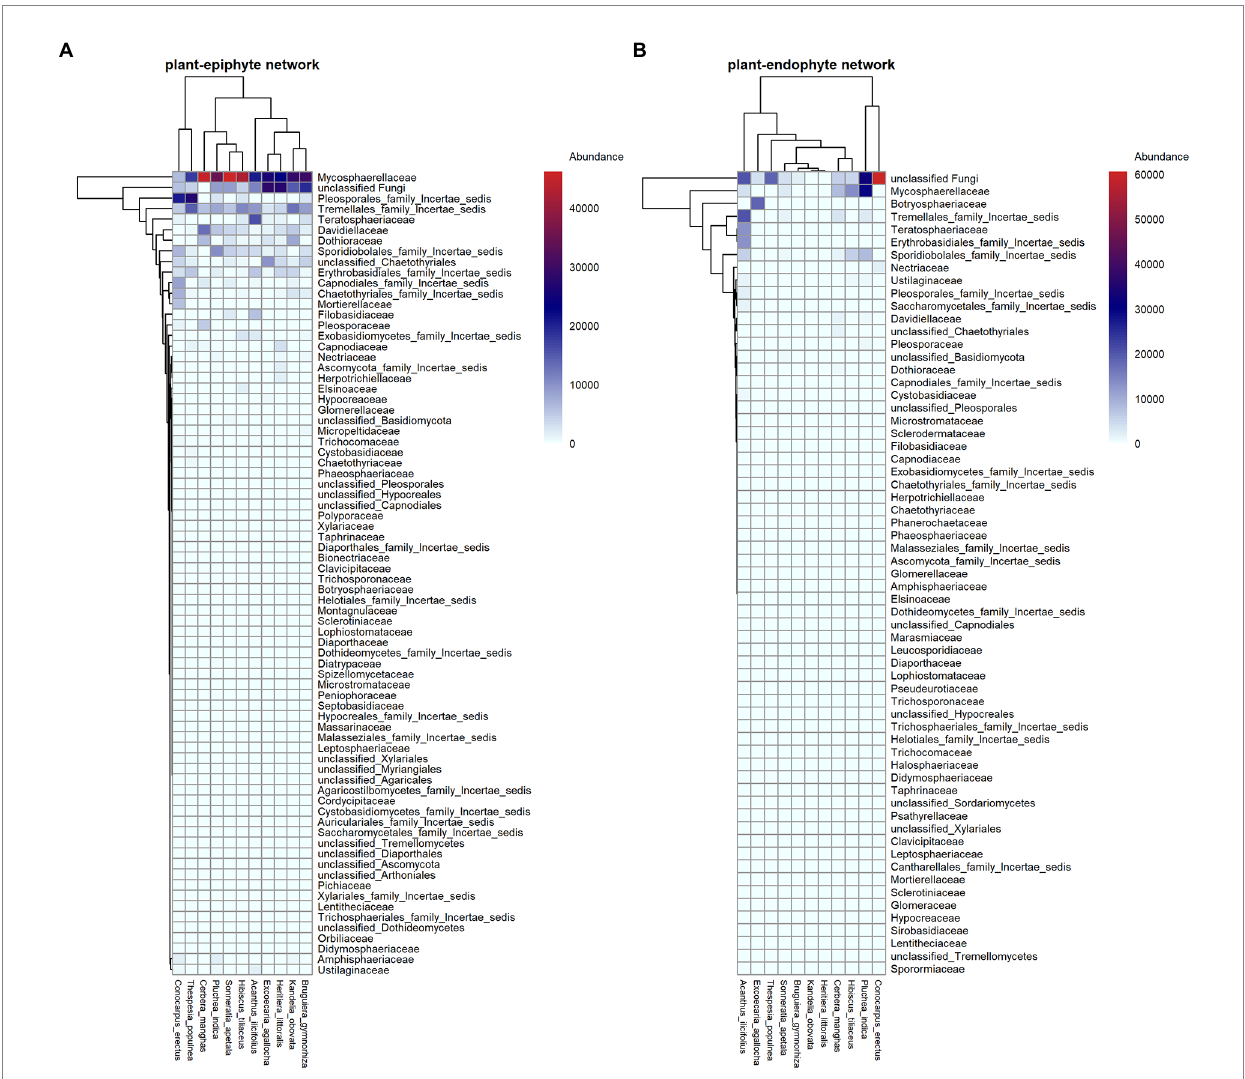
FIGURE 1 Interaction patterns of plant-endophytic fungi (A) and plant-epiphytic fungi (B) . In each panel, plant species and fungal families are shown in columns and rows, respectively. The relative abundance of each fungal family on host plant is filled in the